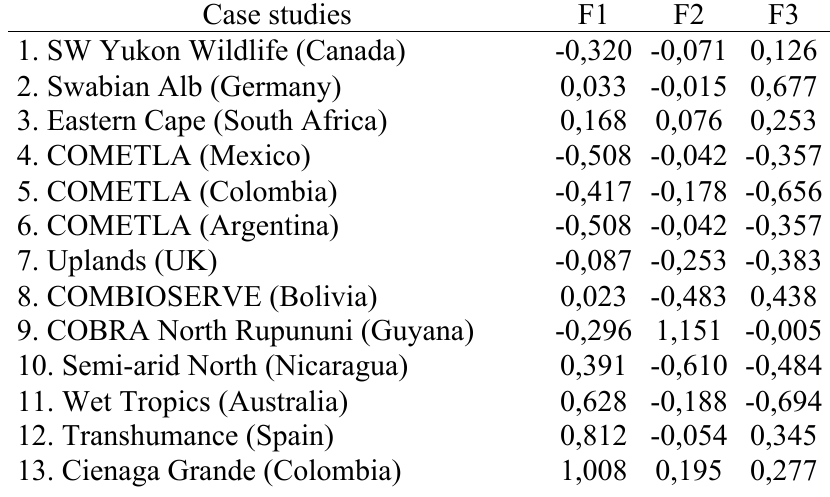
Table A.10.3. Principal coordinates of the case studies in the first three axes (F1, F2, F3) of the Multiple Correspondence Analysis